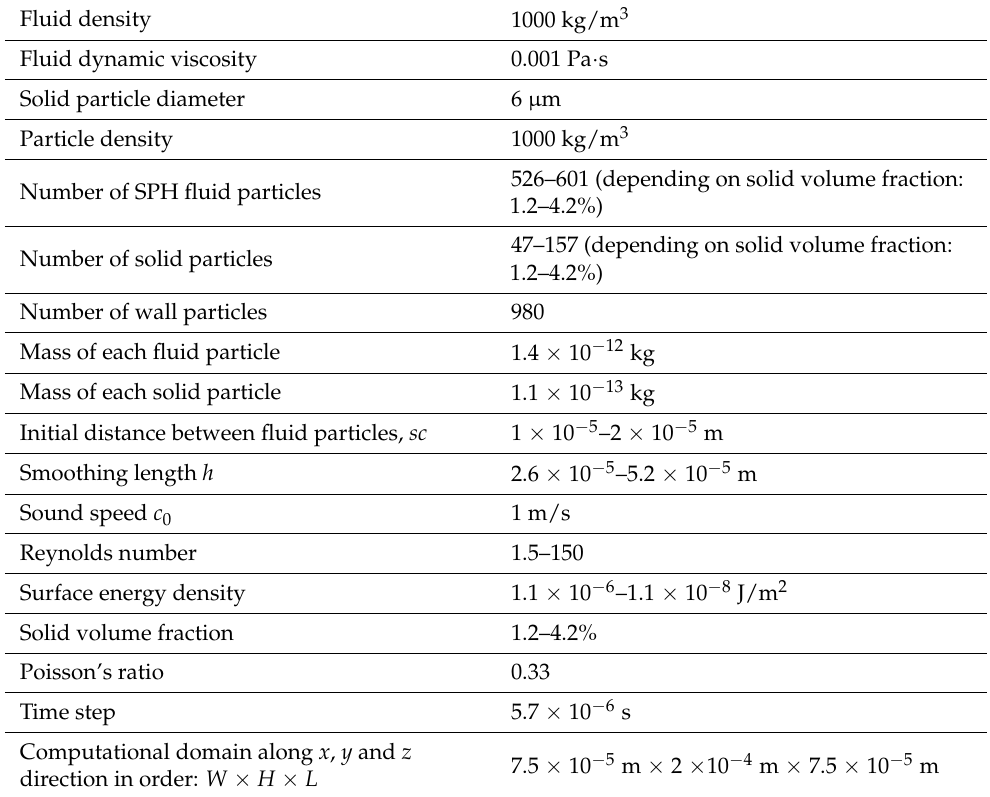
Table 2. Parameters used in the simulation of the structural evolution of solid particle